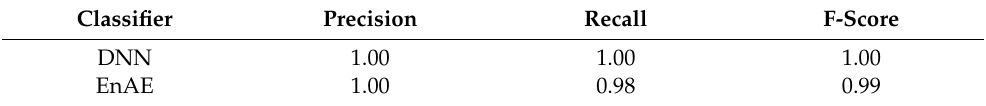
F-score are presented in Table 9. Table 9. DNN and EnAE quality assessment by traditional criteria.